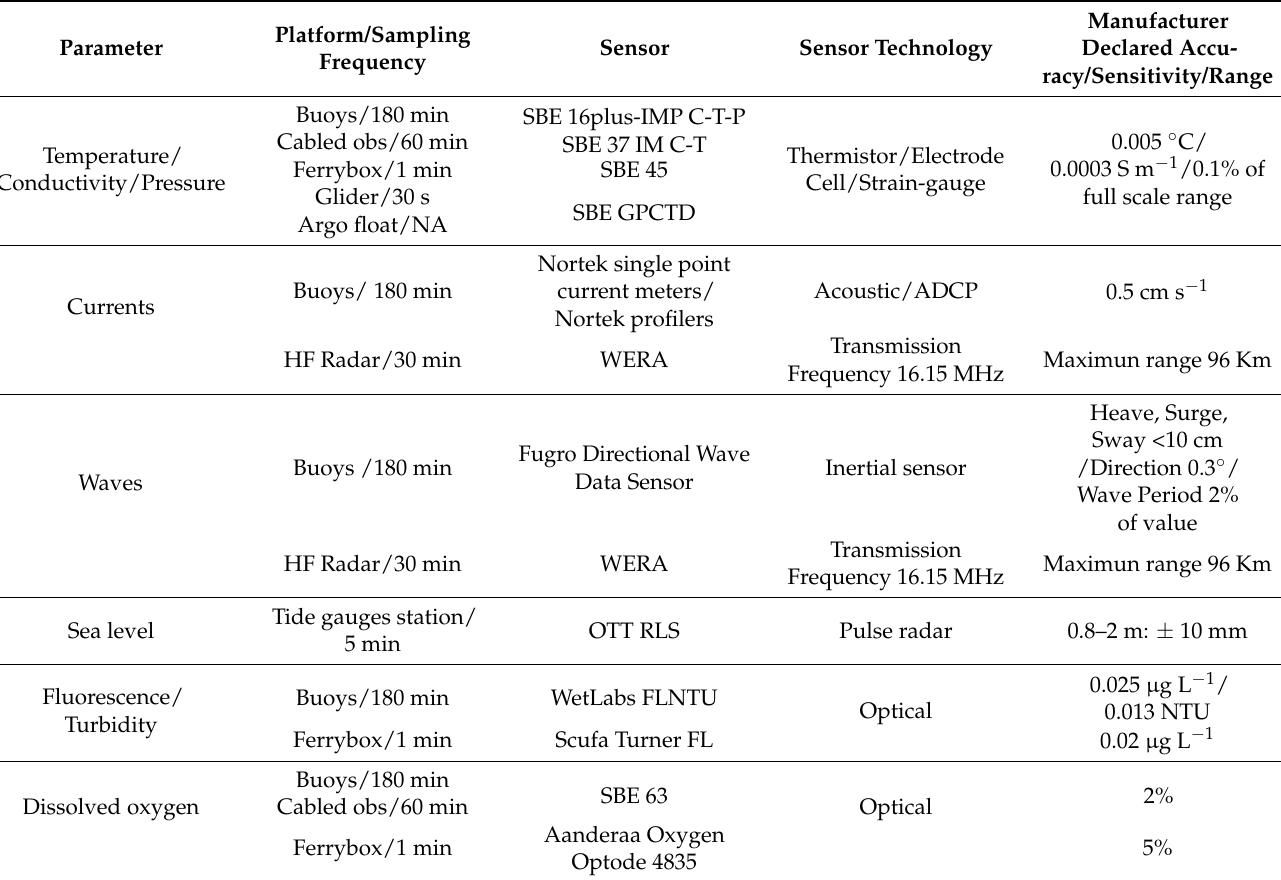
Table 1. The parameters measured and transmitted in NRT for quality control and the oceanographic payload of the system